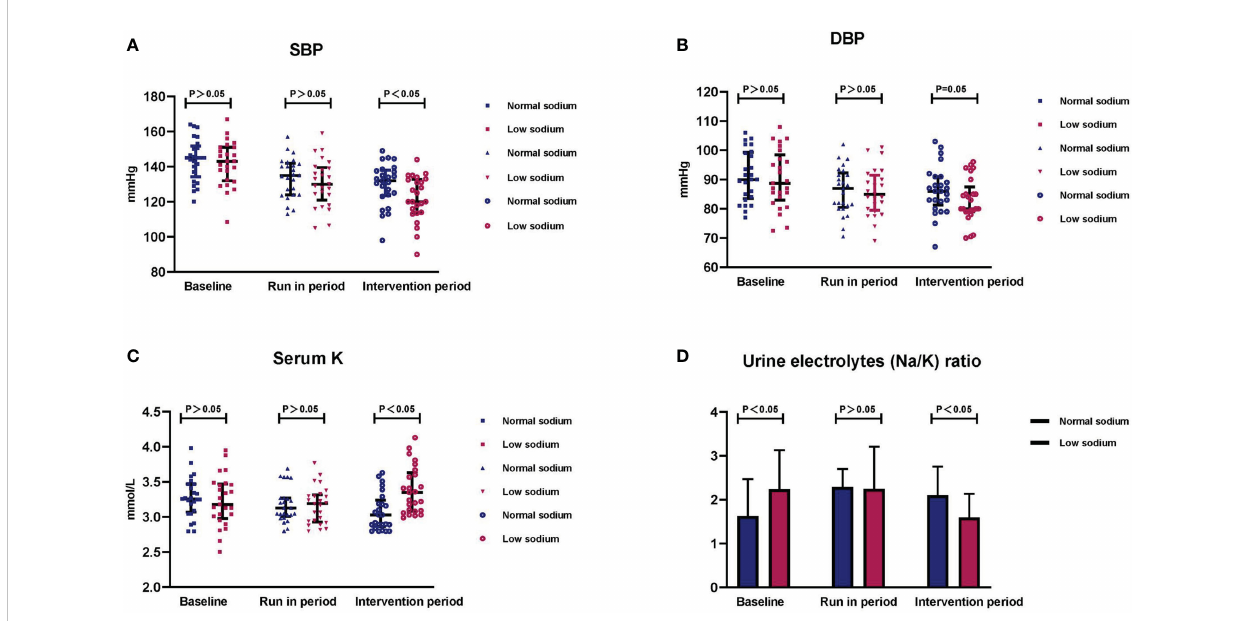
FIGURE 3 Changes in blood pressure, serum potassium, and urinary electrolytes after the dietary intervention. Summary data of (A) SBP, (B) DBP, (C) serum potassium, and (D) 24-h urine sodium to potassium ratio (Na + /K + ) in the two study groups after the intervention period. Data are shown as median with interquartile ranges.